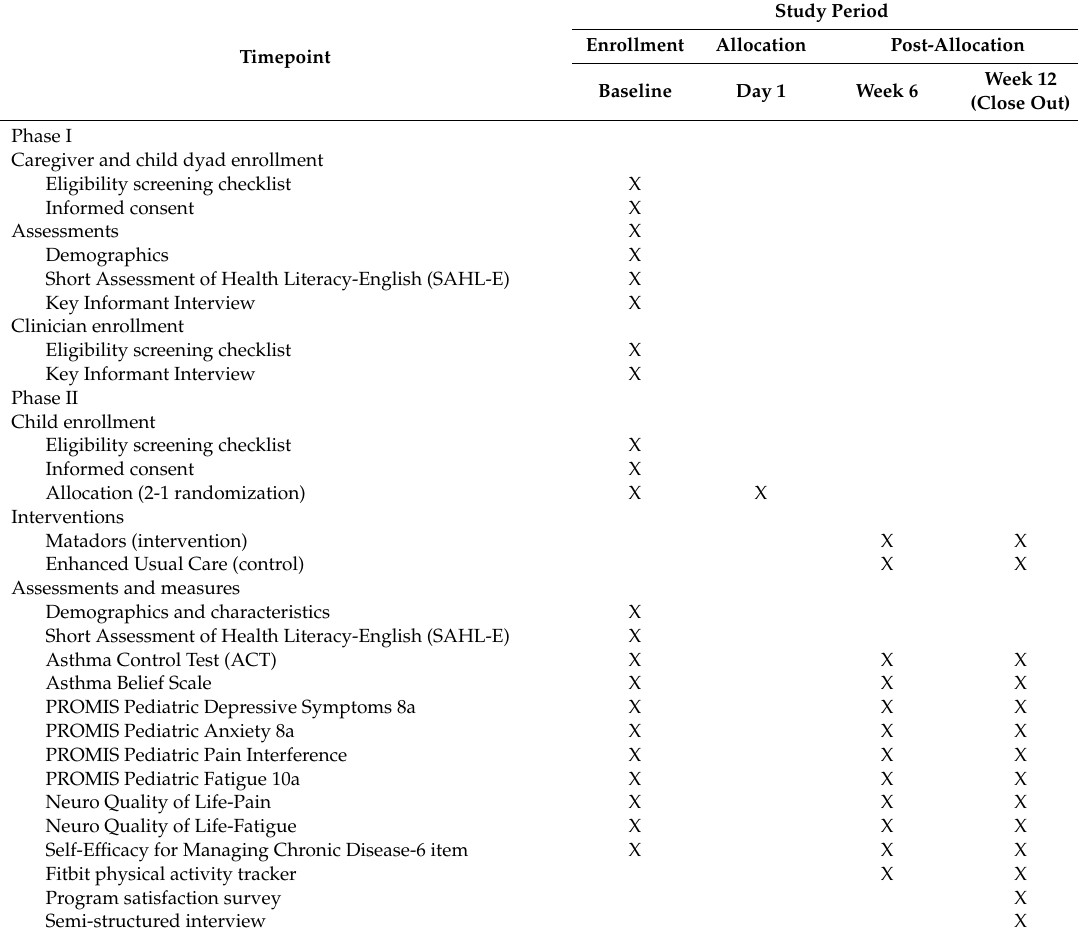
The Standard Protocol Items: Recommendations for Intervention Trials (SPIRIT) diagram (Table